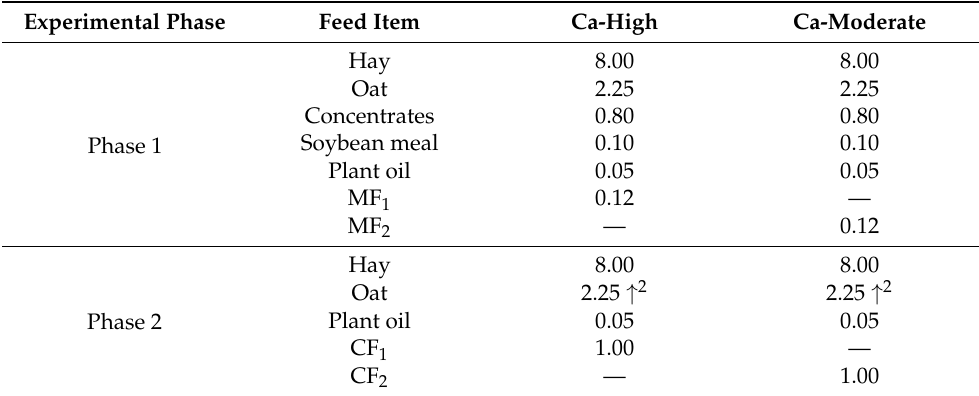
Table 1. Feed supply per animal and day (kg FM 1 , as